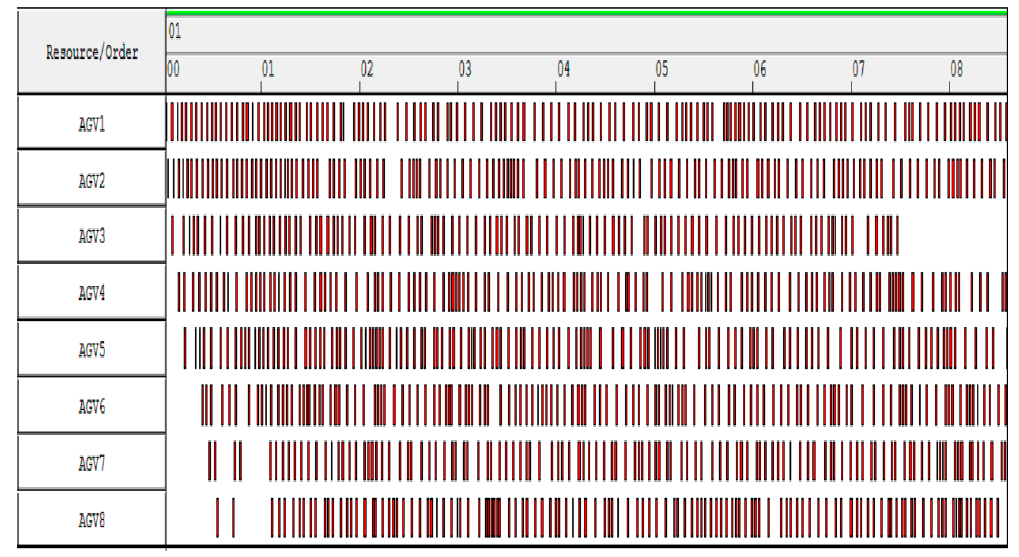
Figure 22. Manual dispatch job Gantt diagram.